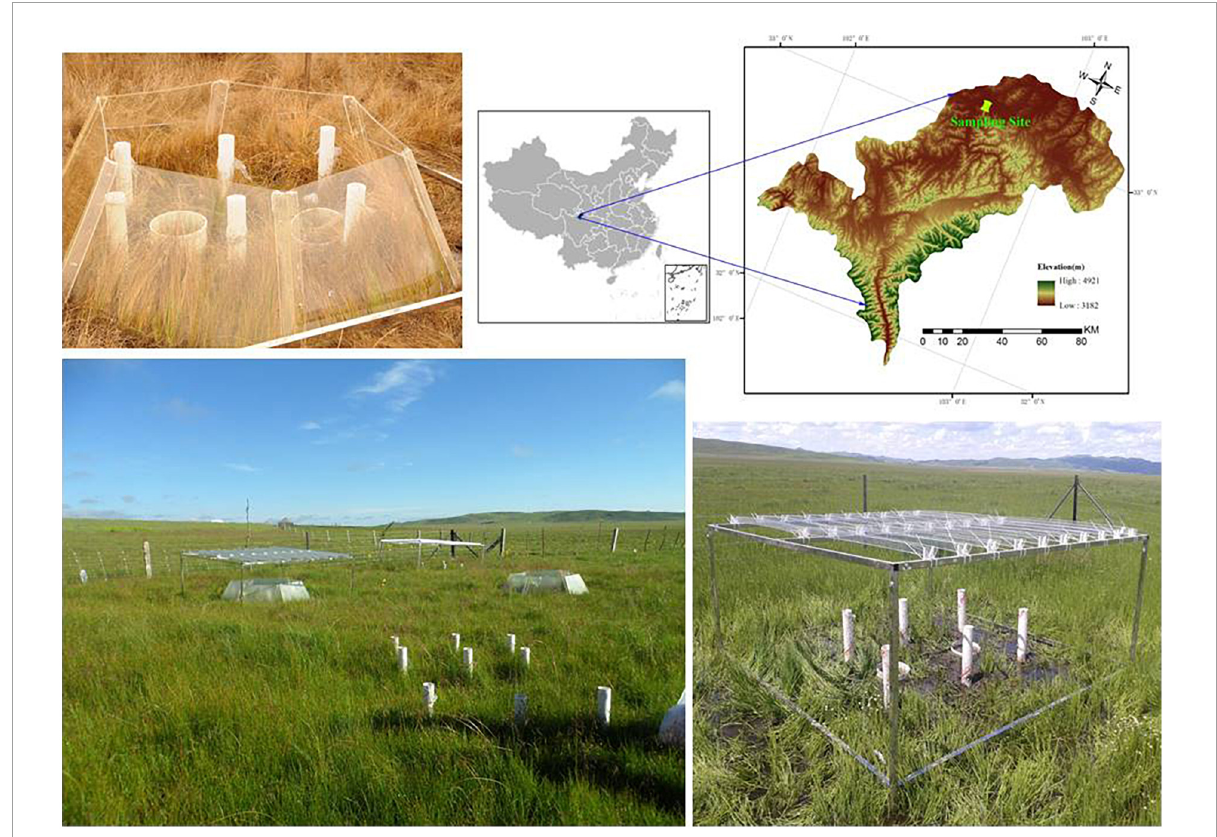
FIGURE1 Location of the sampling site and the appearance of the climate change